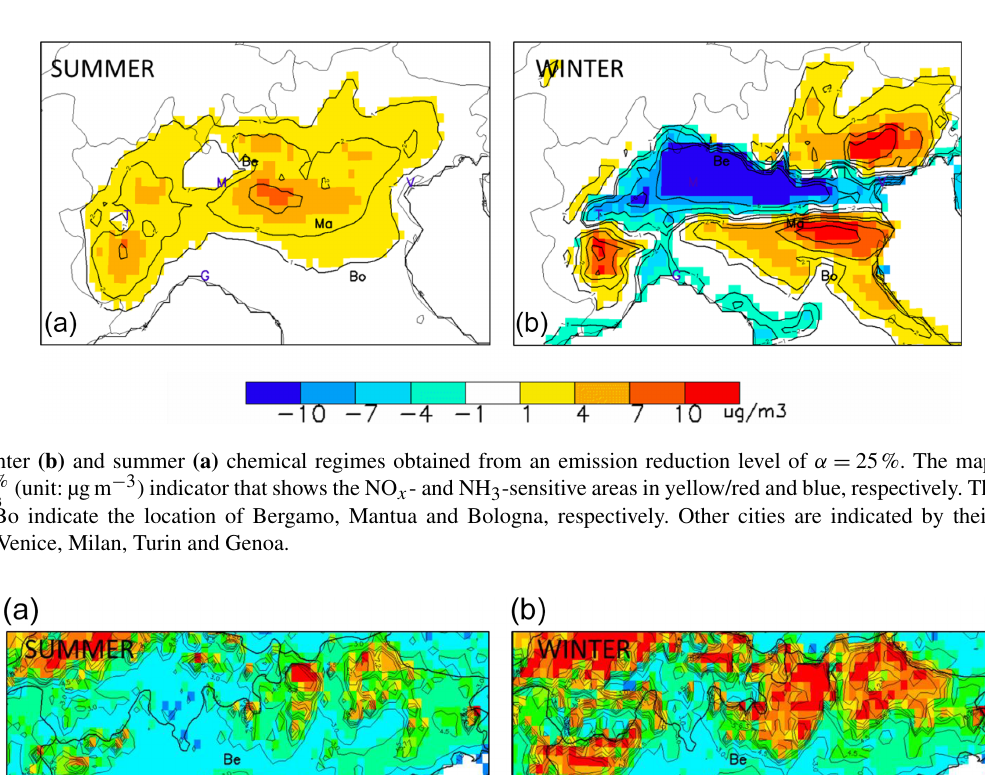
limited regime (top right). Despite this slight change in in- tensity, the regimes therefore keep the same spatial